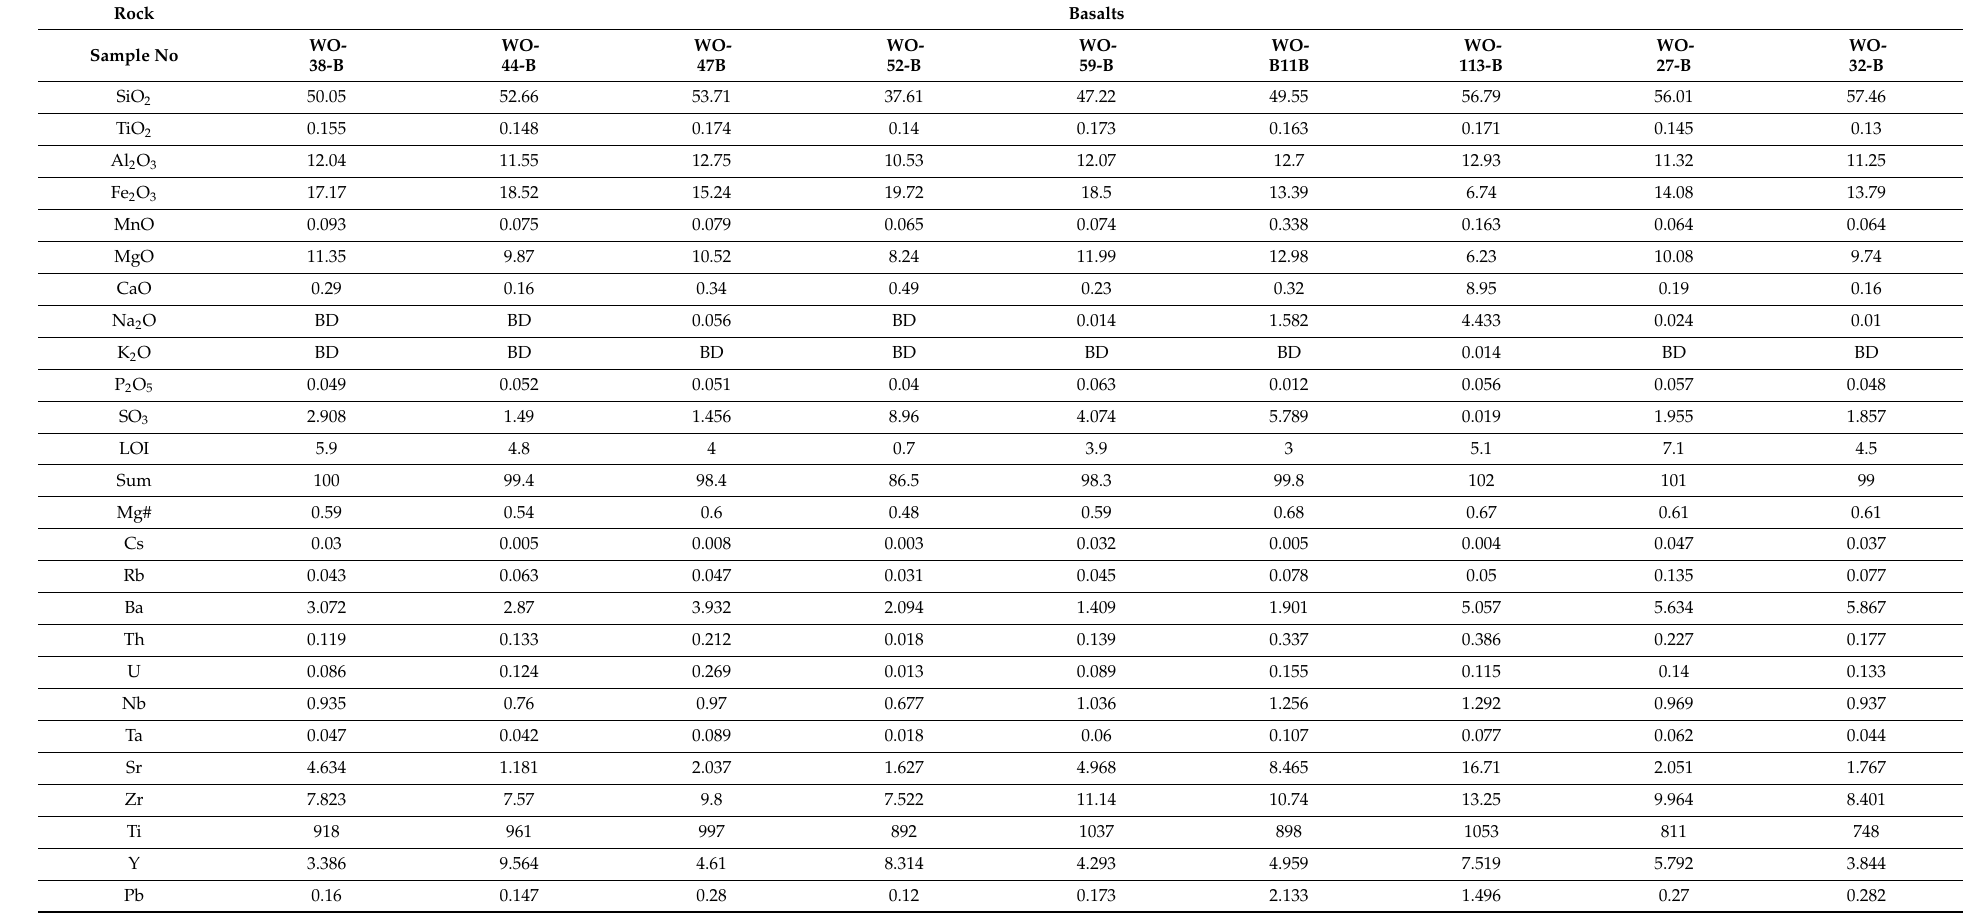
Table 2. Whole rock major elements (in weight %) and trace elements including rare earth elements (in ppm) of the studied basalts from part of the